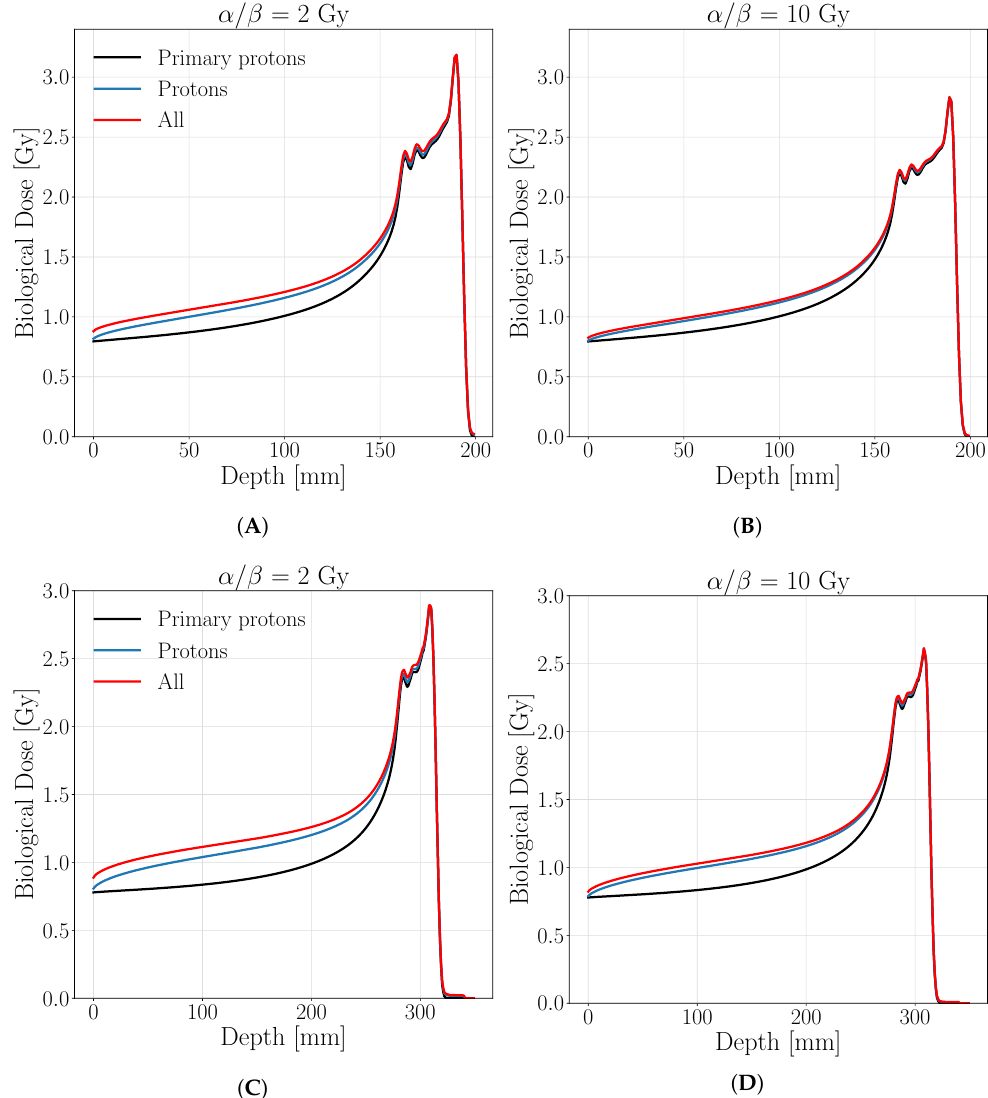
Figure 5. Biological dose for a SOBP calculated with a biological optimization on a target 30 30 30 mm at a depth of 160 mm ( A , B ) and 280 mm ( C , D ) for a tissue of α / β = 2 Gy ( A , C ) × × and α / β = 10 Gy ( B , D ). The black line represents the biological dose obtained by considering only primary protons, the blue one is obtained including all protons while in red all protons and target fragment contribution. The legend stands for both